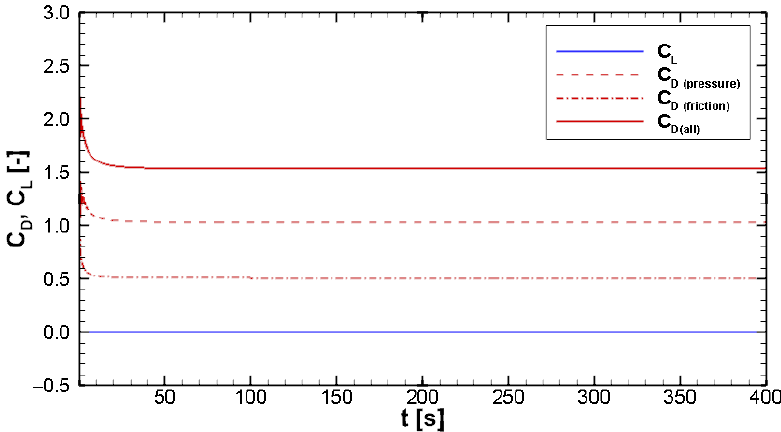
Figure 10. Comparison of pressure coefficients on the cylinder surface ( Re = 40).